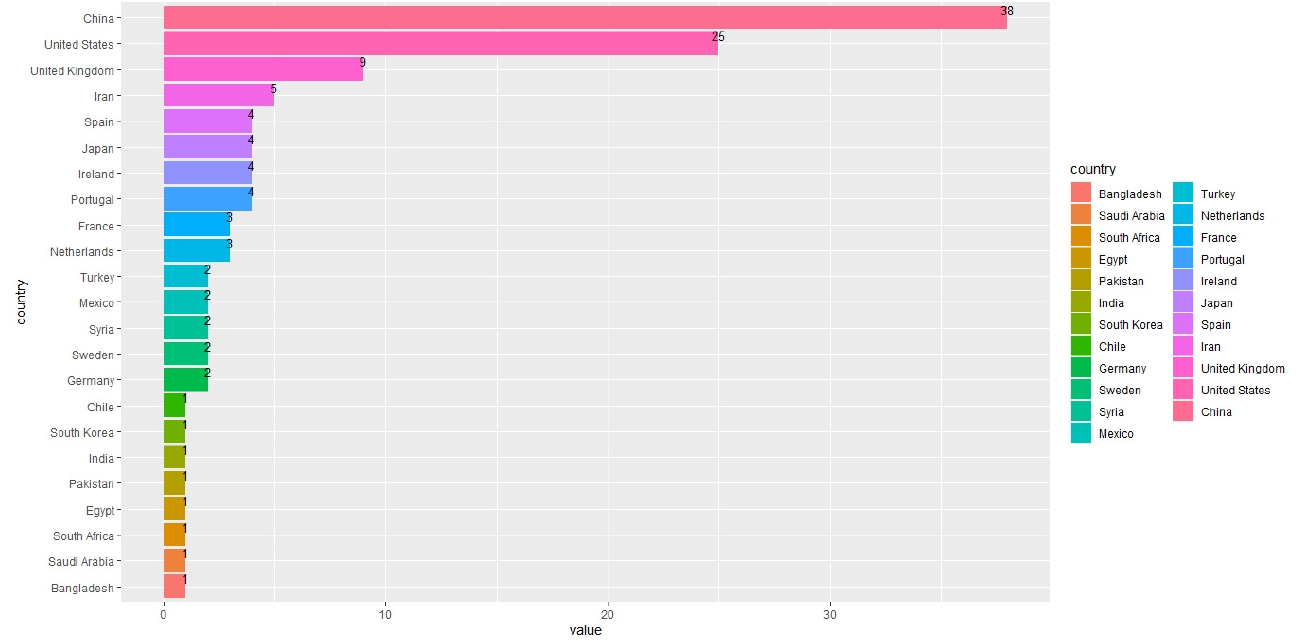
Figure 6. Distribution by country, based on origin of corresponding author.